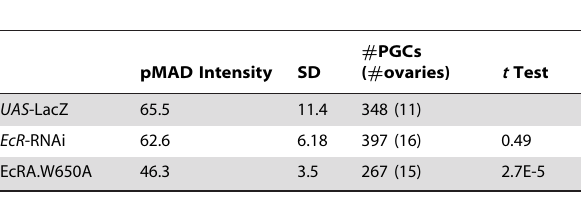
Table 2. Effects of abrogation of ecdysone signaling on niche